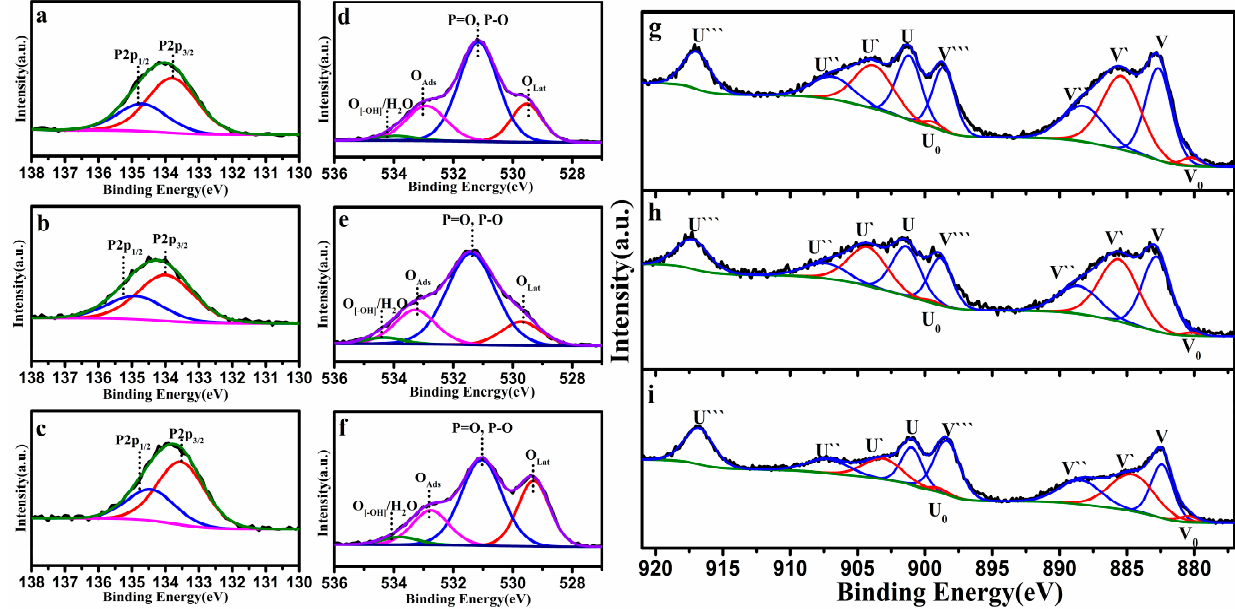
Figure 8. XPS spectra of deactivation CeO 2 nanomaterials ( a ) P2p of 2MCeO 2 np, ( b ) P2p of 12MCeO 2 nr, ( c ) P2p of 12MCeO 2 nc, ( d ) O1s of 2MCeO 2 np, ( e ) O1s of 12MCeO 2 nr, ( f ) O1s of 12MCeO 2 nc, ( g ) Ce3d of 2MCeO 2 np, ( h ) Ce3d of 12MCeO 2 nr, and ( i ) Ce3d of 12MCeO 2 nc.